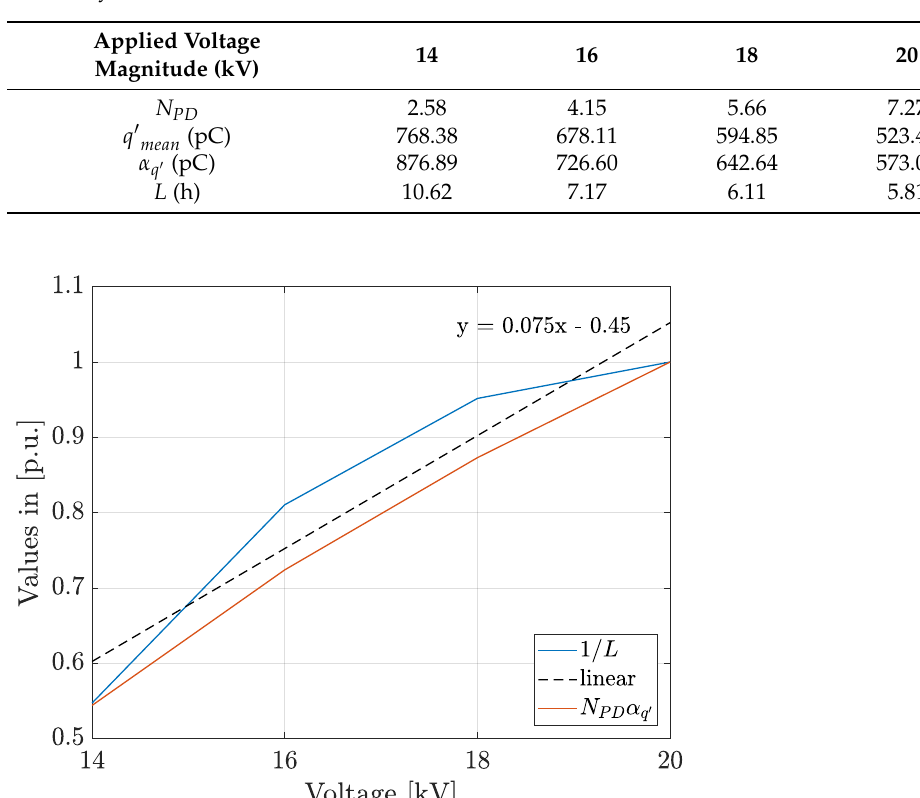
Table 4. Summary of the typical simulation results for each applied voltage magnitude in the sec- ond case study.